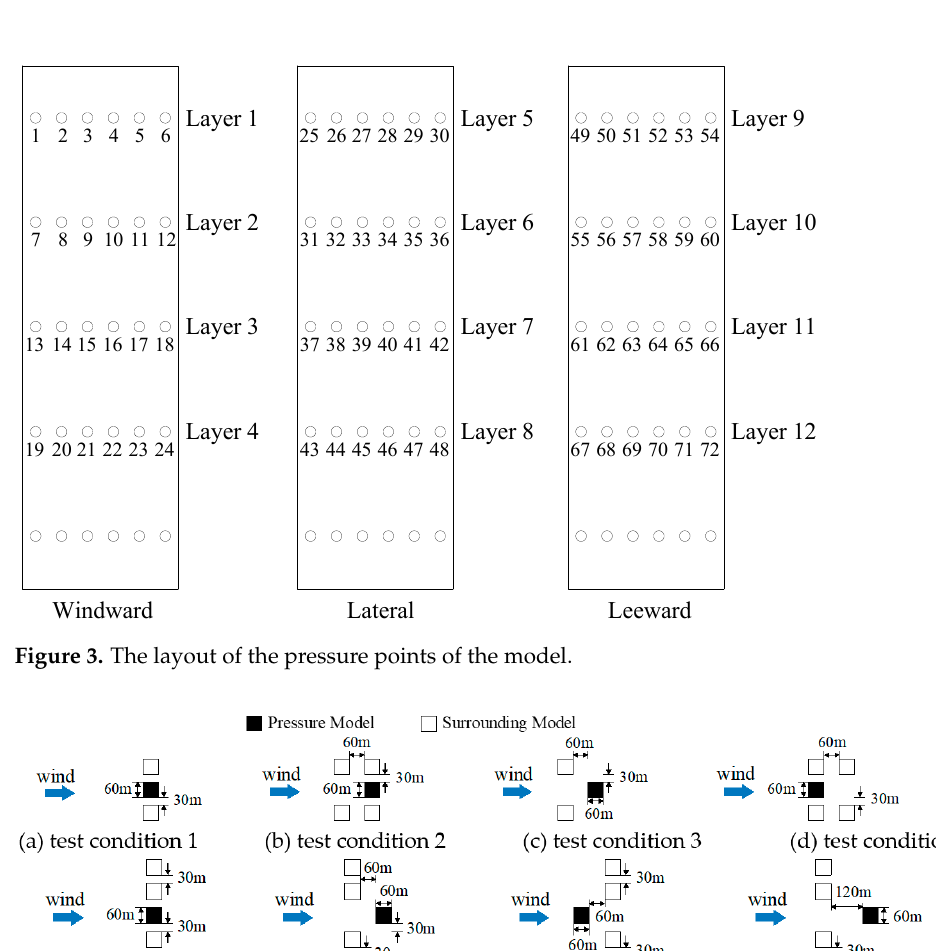
Figure 4. The layout of the real grouped tall buildings.